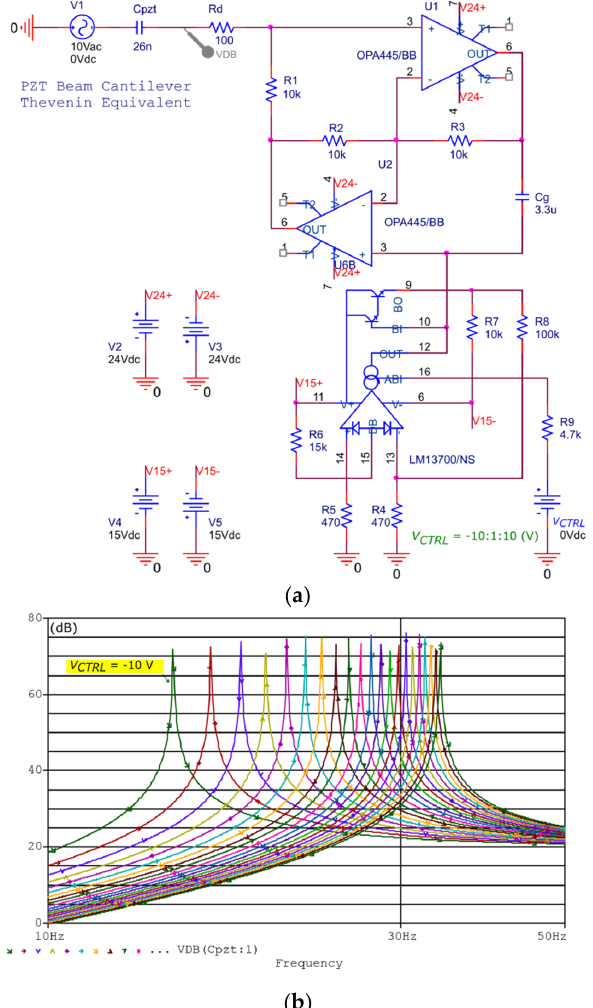
Figure 4. Voltage-controlled synthetic inductor: ( a ) based on an LM13700 operational transconductance amplifier, and ( b ) the resonance frequency simulation results for the voltage control ( V CTRL ) from −10 V to 10 V with 1 V steps.